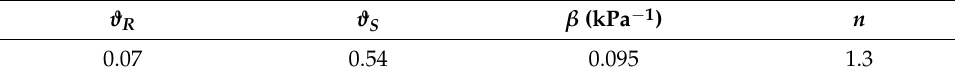
Table 1. Van Genuchten model’s parameters (data drawn from [50]).